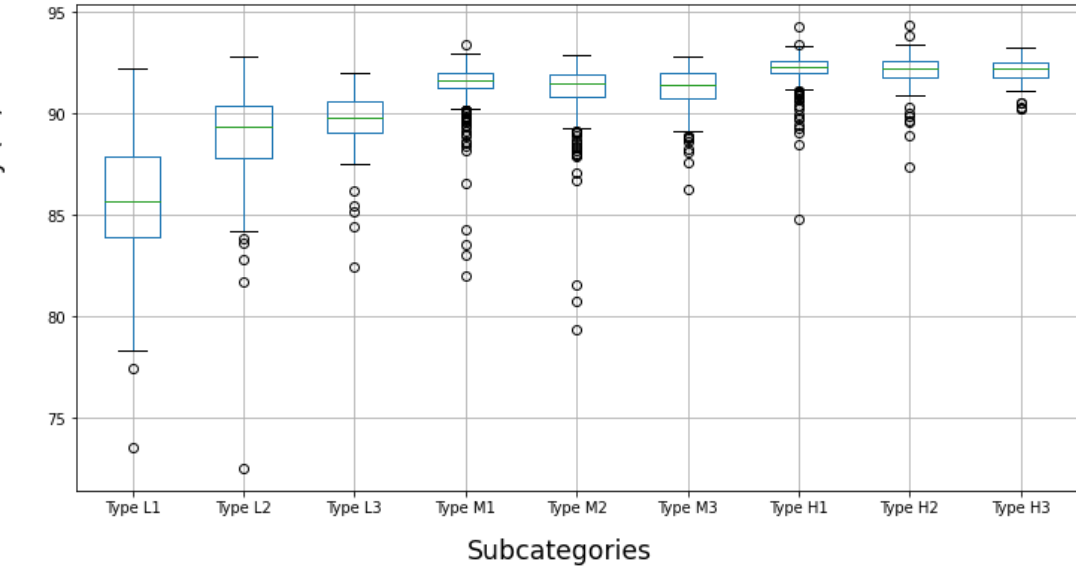
Figure 21. Inverter efficiency in the clusters L1, L2, L3, M1, M2, M3, H1, H2 and H3.